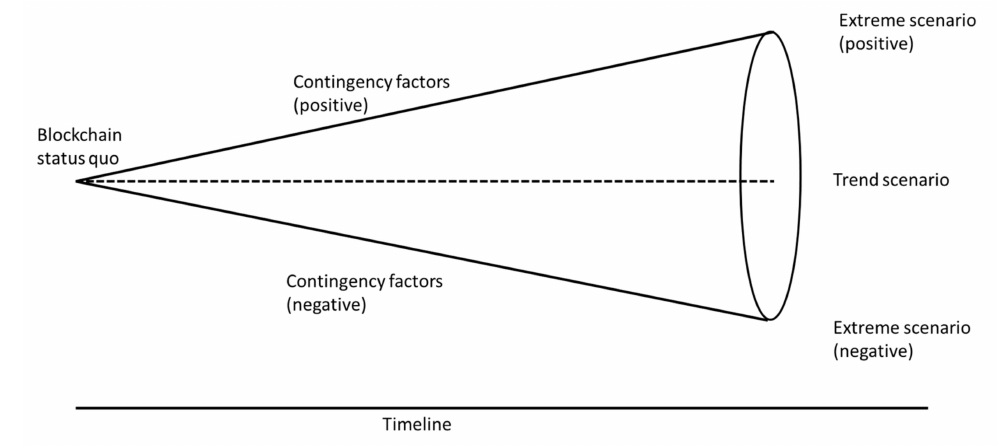
Figure 2. Scenario